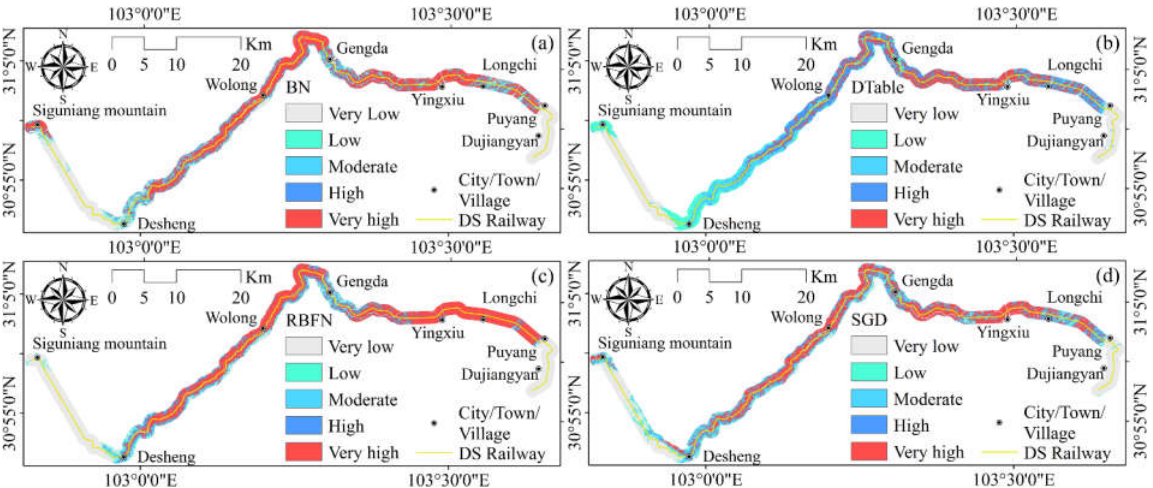
Figure 10. LSMs for the railway 1 km buffer zone produced by the ( a ) BN model, ( b ) DTable model, ( c ) RBFN model, and ( d ) SGD model.